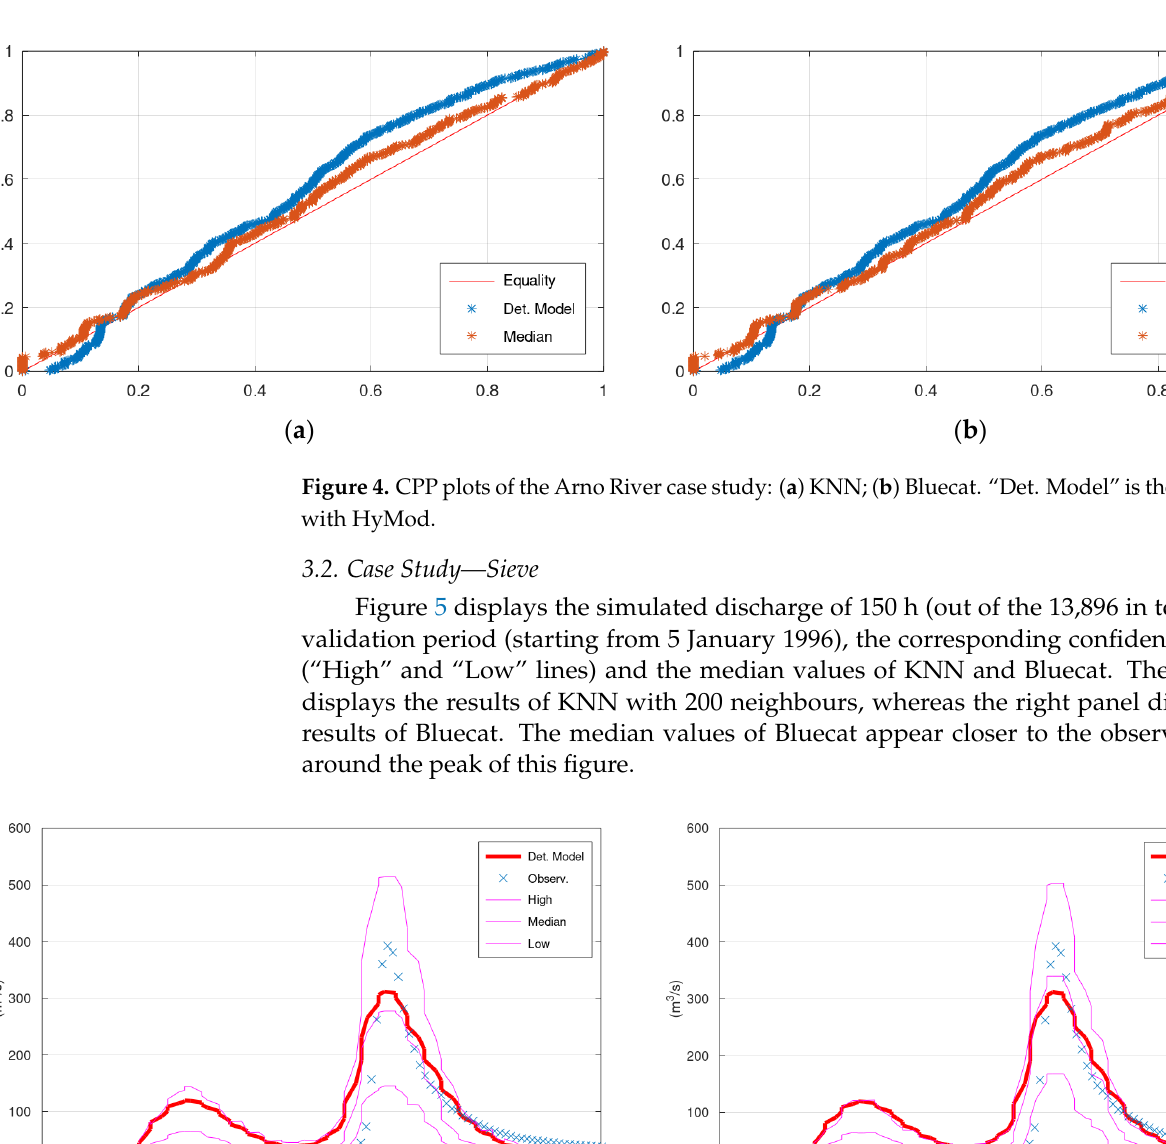
Figure 3. Scatter plot of the Arno River case study: ( a ) KNN; ( b ) Bluecat.